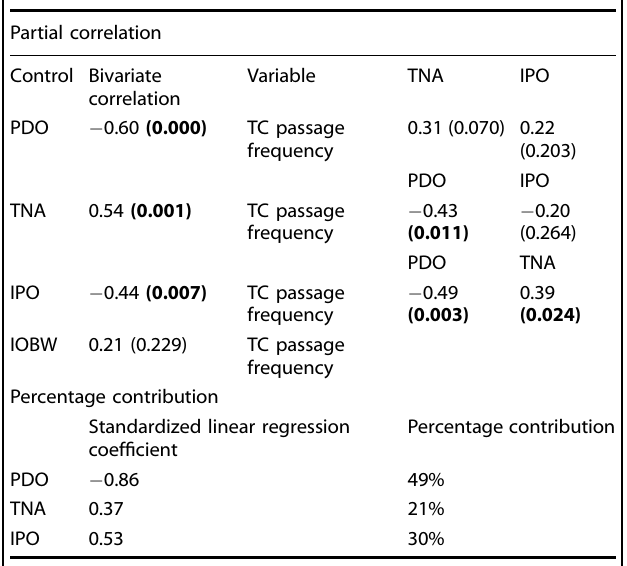
Table 2. Bivariate and partial correlation of indicated climate index and their percentage contribution to TC passage frequency in East